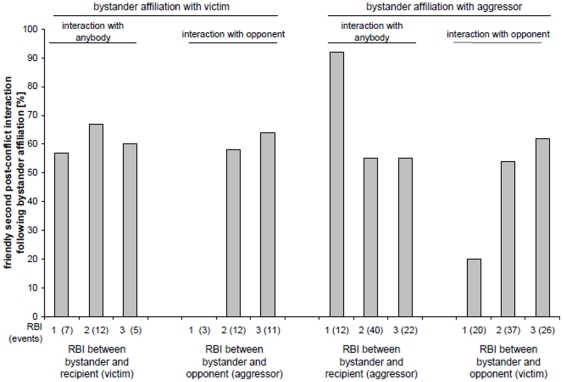
Percentage of friendly interactions during the second post-conflict interaction by the recipient of affiliation, following bystander affiliation with the victim (left) or with the aggressor (right).This is dependant on the RBI of the bystander with either the recipient of affiliation (left) or the recipient's opponent (right).